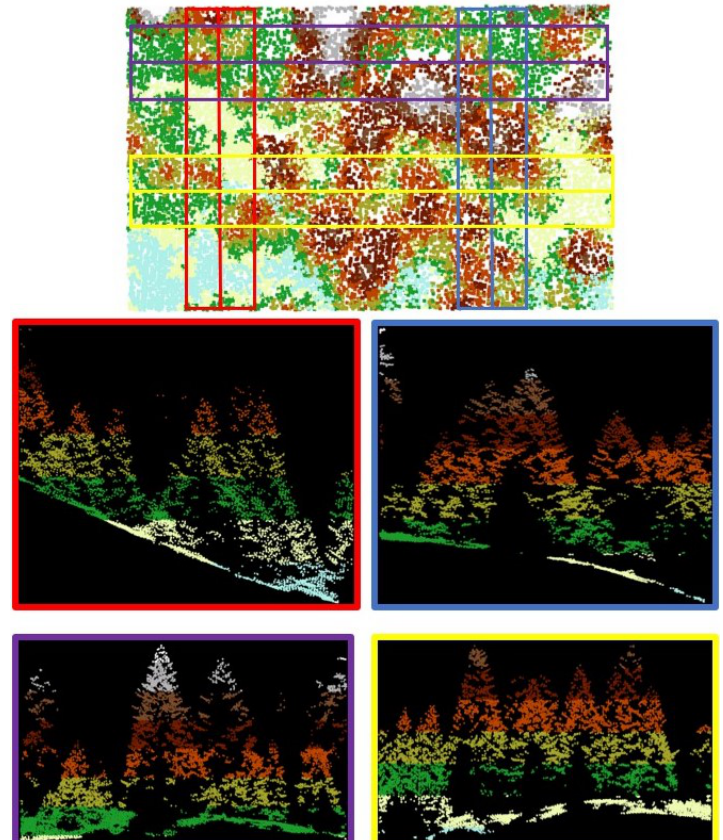
Figure 12. Vertical cross sections of plot 10 which was significantly underestimated for its CBH. The presence of understorey vegetation being close or overlapping with the CBH can be visually